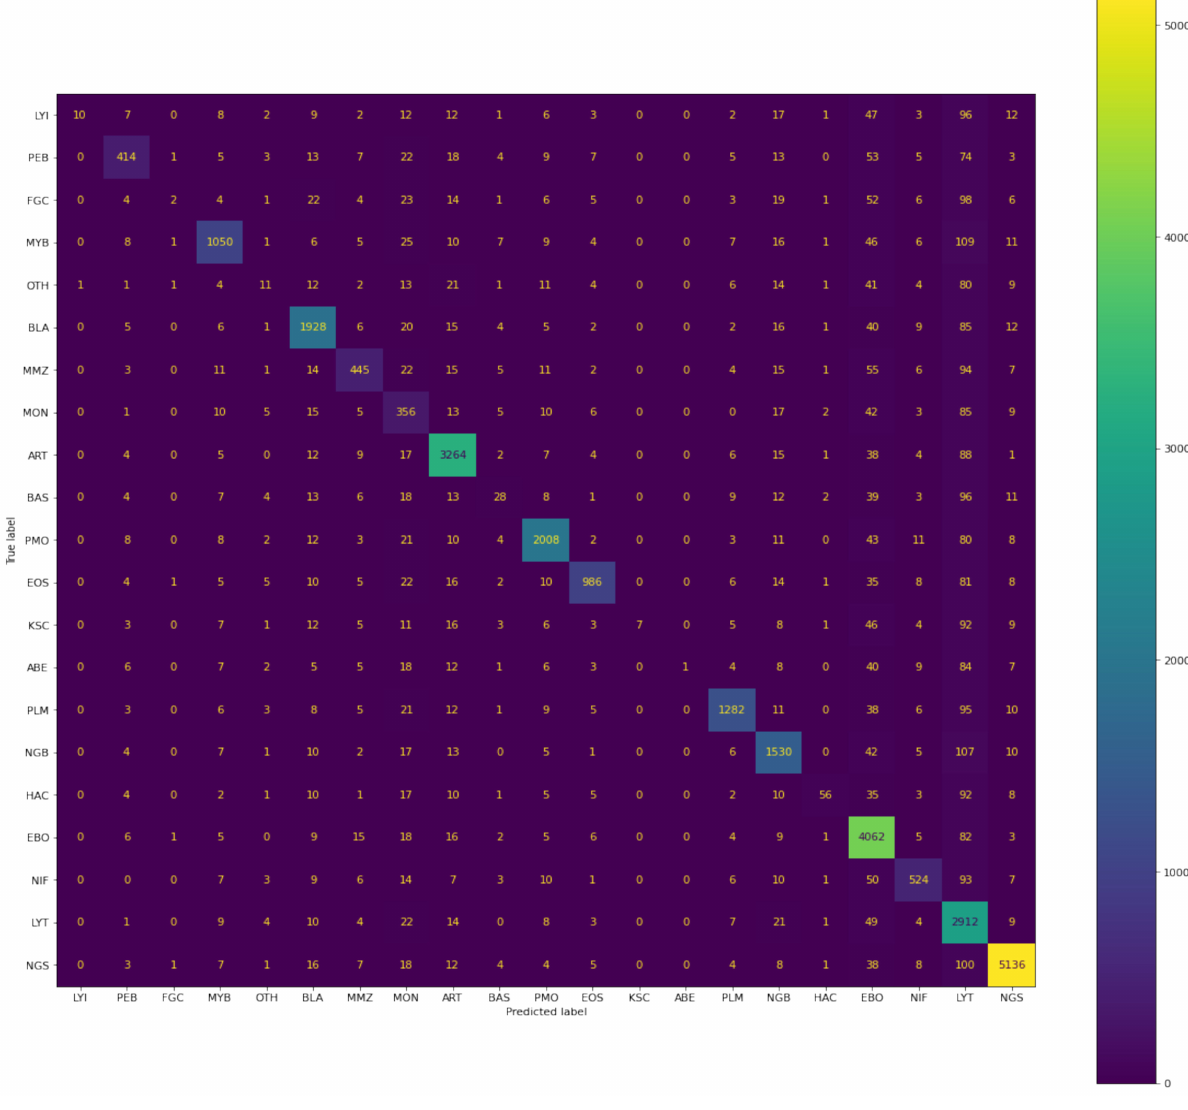
Figure 13. Confusion matrix of predictions generated by Siamese model on test